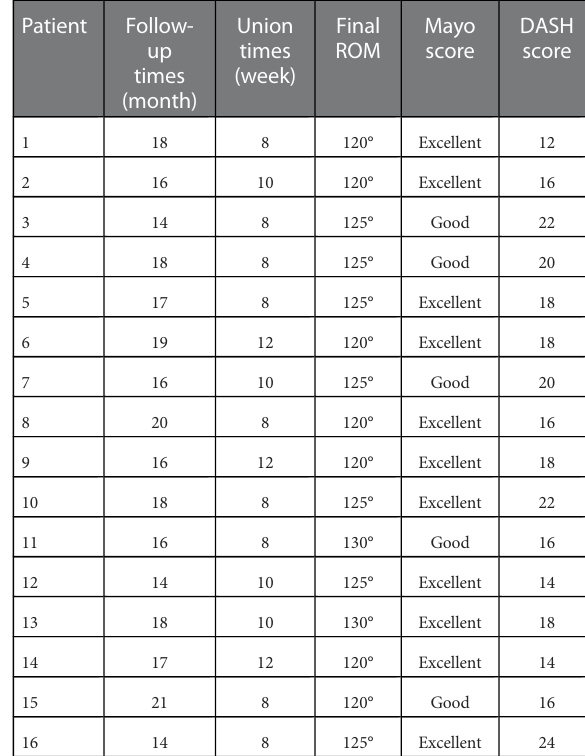
TABLE 2 Clinical results and follow-up data. Patient Follow-